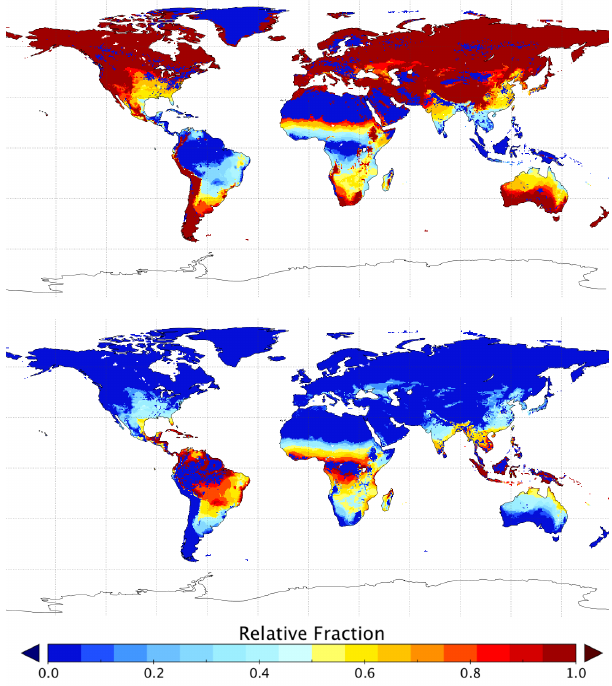
Figure 6. Relative fractions of C3 (top) and C4 (bottom) grassland on global 0.5 ◦ scale under the present climate